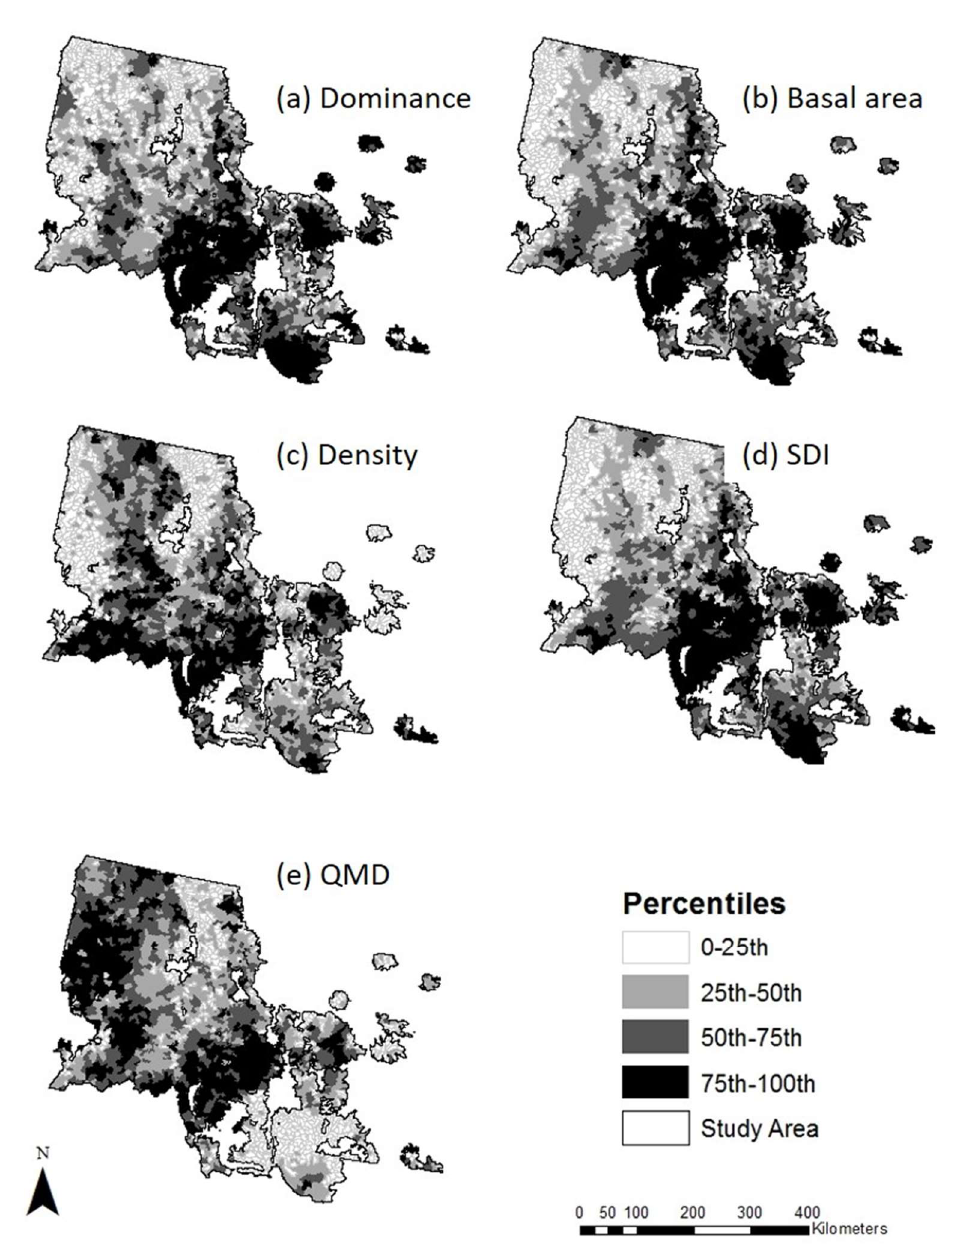
Figure 3. Spatial distribution of subwatershed mean LPP forest parameters by percentile for lodgepole ( a ) dominance, ( b ) basal area, ( c ) density, ( d ) stand density index and ( e ) quadratic mean diameter. See Table 1 for variable description.